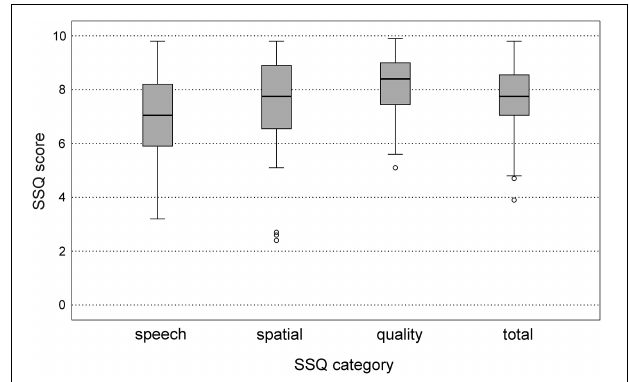
FIGURE 7 | Boxplots of speech, spatial, and qualities of hearing scale (SSQ) scores for the three subsets speech, spatial, quality, and for the mean total SSQ score.